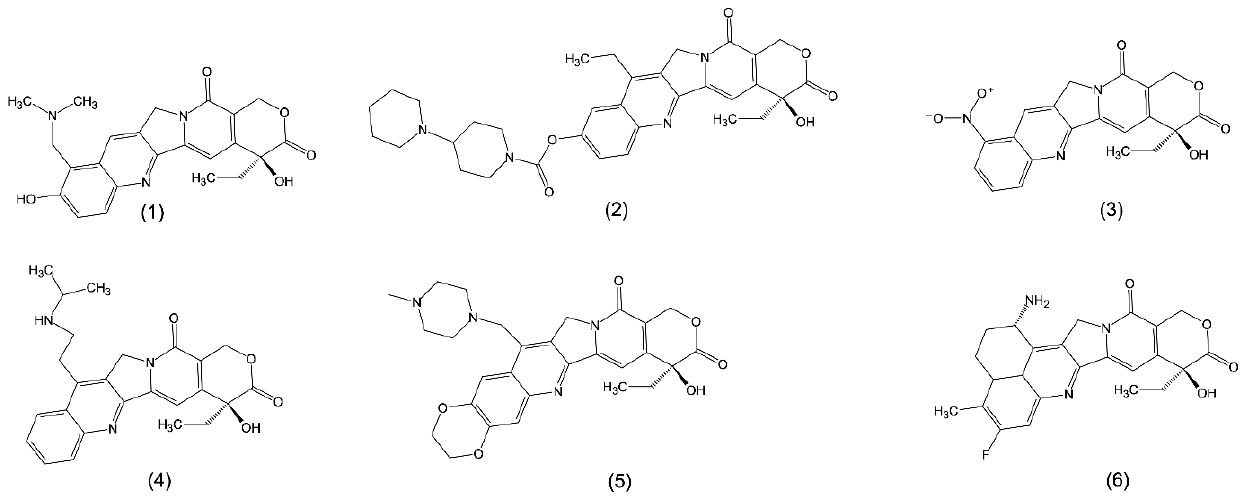
Figure 3. Structures of CPT analogues: topotecan (1); irinotecan, CPT-11 (2); rubitecan, 9-CPT (3); belotecan, CKD-602 (4); lurtotecan, GG-211 (5); exatecan, DX-8951f (6). Belotecan (CKD-602) (Figure 3 (4)), on the other hand, has recently been shown to have an antitumor effect in cervical cancer in both in vitro and in vivo models.